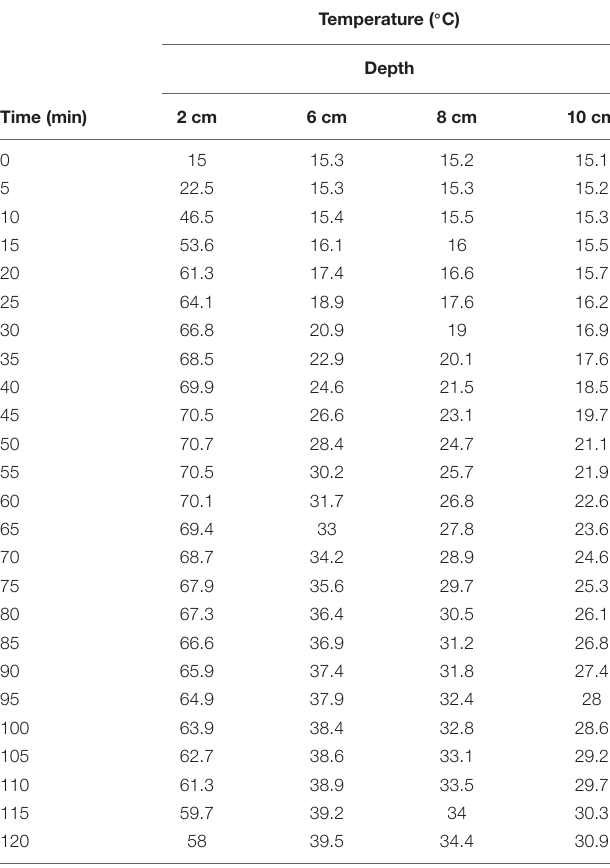
TABLE 4 | The second group of temperature data; air temperature 20 ◦ C, HMA temperature 155 ◦ C.